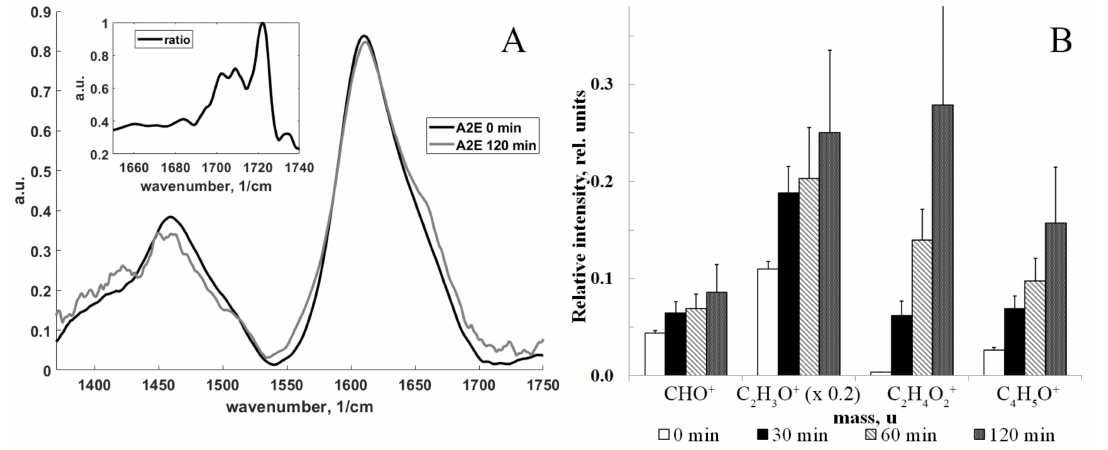
Figure 1. A2E oxidation under light exposure. ( A ) Raman spectra of BCARS. ( B ) Comparison of intensities of positive fragment ions containing carbonyl groups obtained by ToF-SIMS. Raman spectra data are means (means ± SD) of three assays, each with 25 spectra; p < 0.05. Insert in Figure 1A—the ratio of the A2E bands (after light irradiation/before light irradiation) in the range of 1660–1740 1/cm, which is the range of aldehyde and ketone vibration bands; the ion with m / z = 43 was multiplied by a factor of 0.2; ToF-SIMS data are means (means ± SD) of nine assays; p < 0.01.